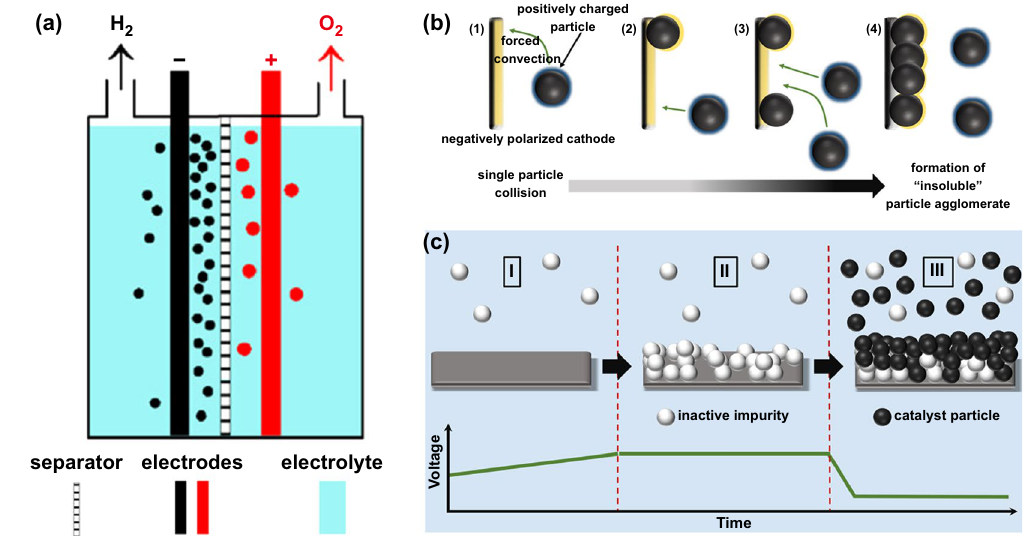
Fig. 3 a Schematic diagram of conventional alkaline electrolyzer. Reproduced with permission from Ref. [68]. Copyright 2012 Elsevier Inc., b schematic diagram of the formation of the catalyst film, c schematic diagram of cathode deactivation caused by the deposition of trace metal impurities and the change of the overall voltage in the electrolytic cell. Reproduced with permission from Ref. [69]. Copyright 2018 Elsevier